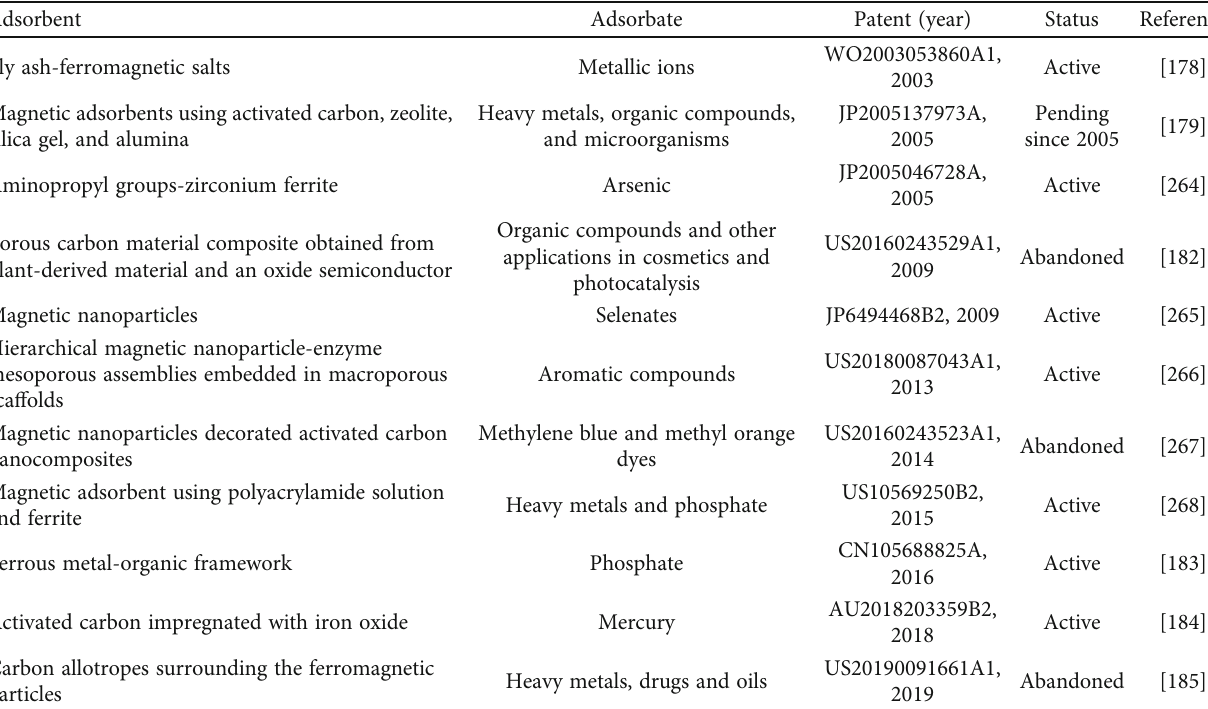
Table 7: Summary of patents related to the preparation of carbon-based magnetic